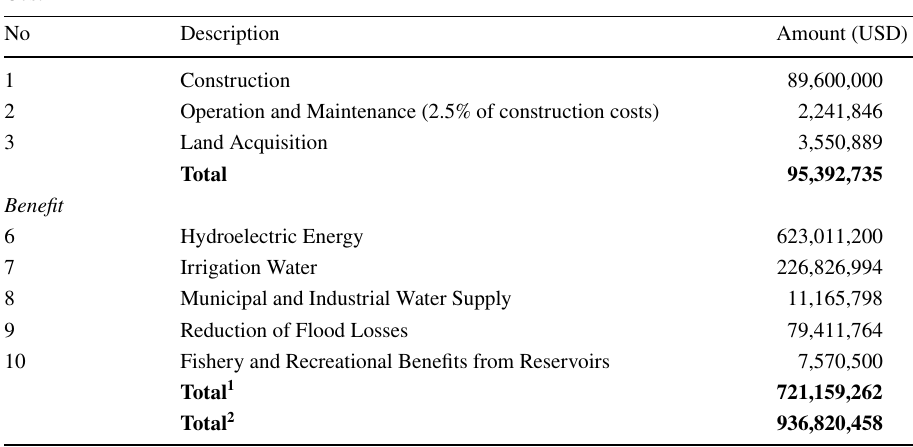
Table 9 CBA results for the dam construction with an effective life span of 50 years